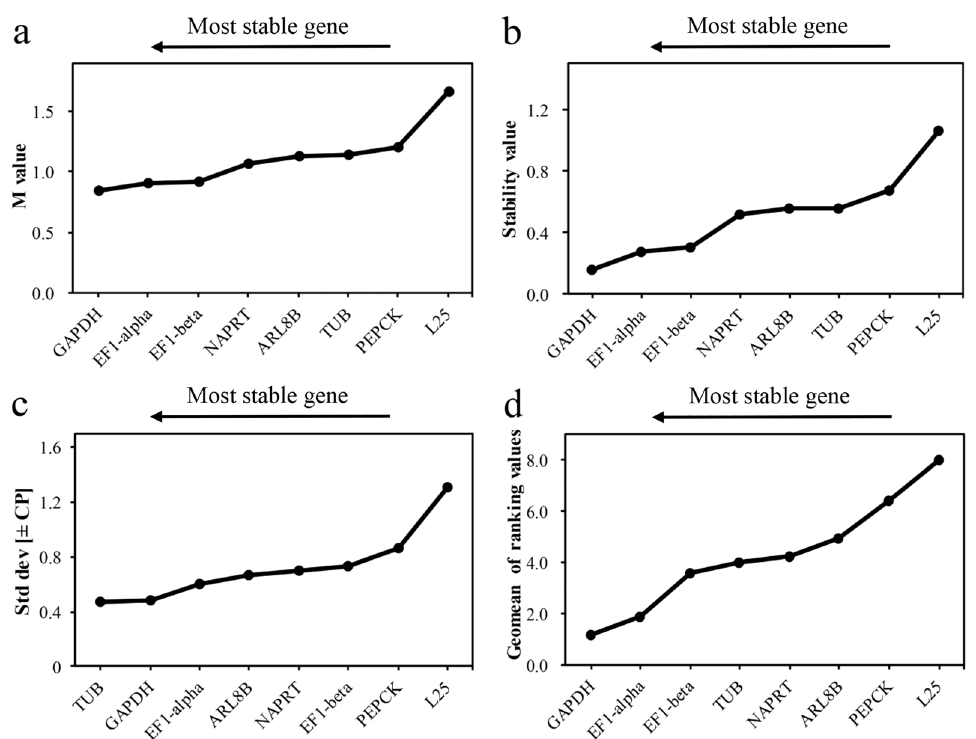
Figure 6. Expression stability of eight candidate reference genes in total of P. ternata as calculated by GeNorm ( a ), NormFinder ( b ), BestKeeper ( c ) and refFinder ( d